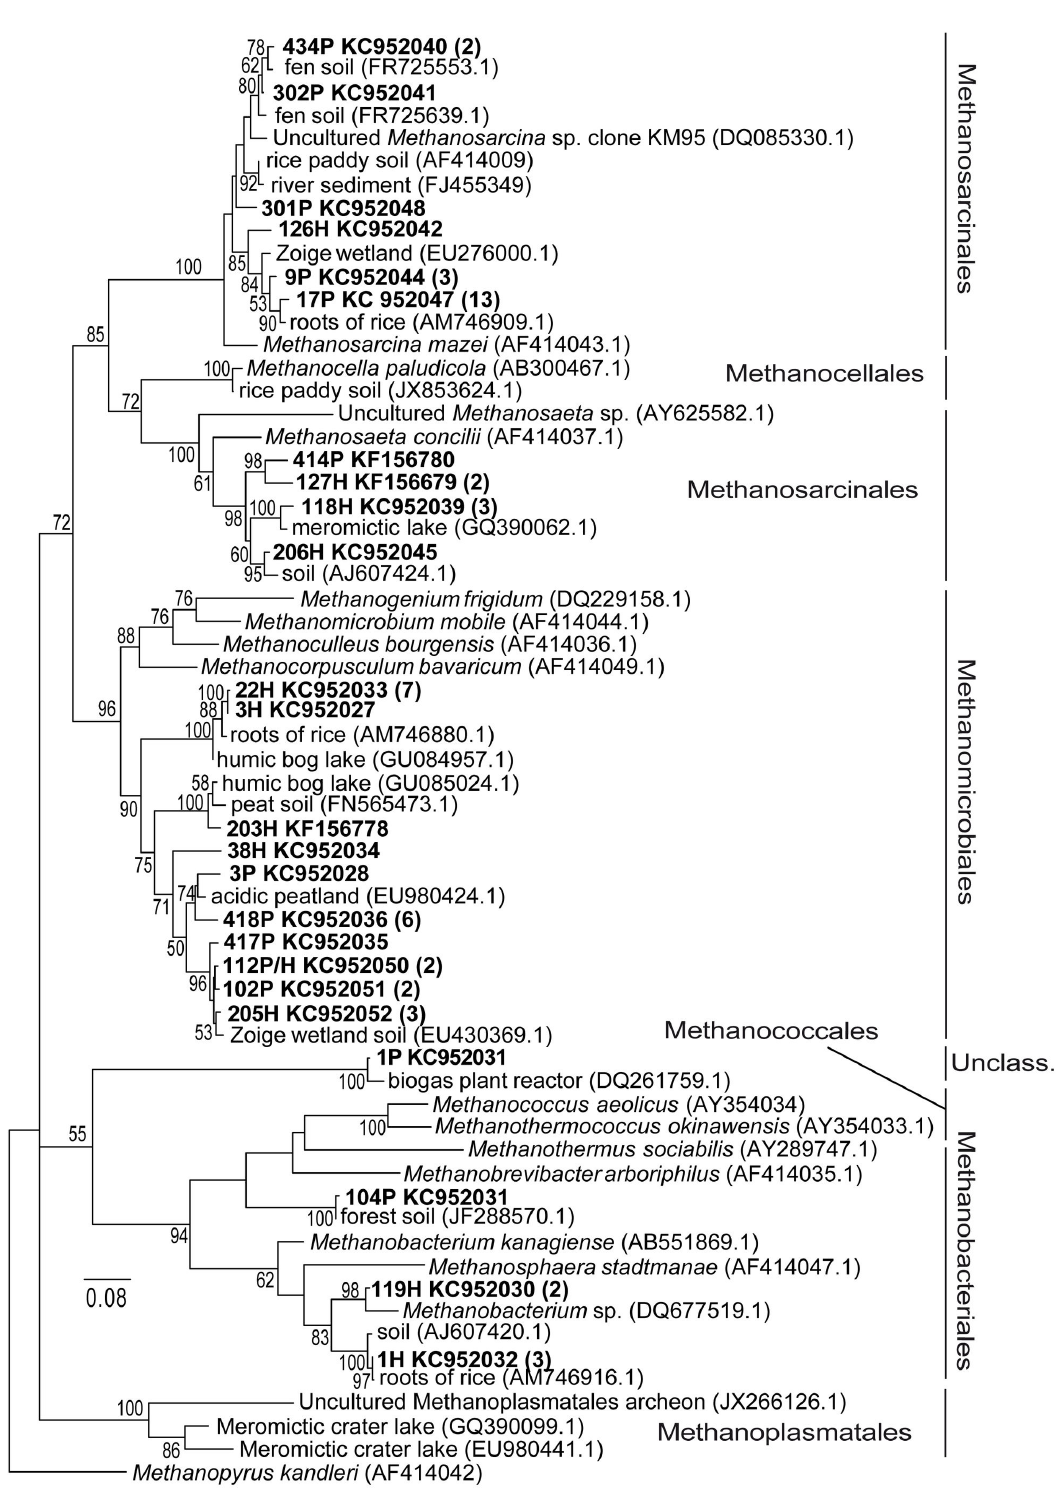
Figure 1. Phylogenetic tree of mcrA gene clone (phylotype) sequences retrieved from hyporheic river sediment. The clones come from upper sediment layer (0-25 cm depth) are described as „P“, clones come from deeper sediment layer (25-50 cm depth) are described as „H“. The numbers in parenthesis indicate the number of clones. The phylogenetic tree is rooted with Methanopyrus kandleri . doi: 10.1371/journal.pone.0080804.g001 PLOS ONE |